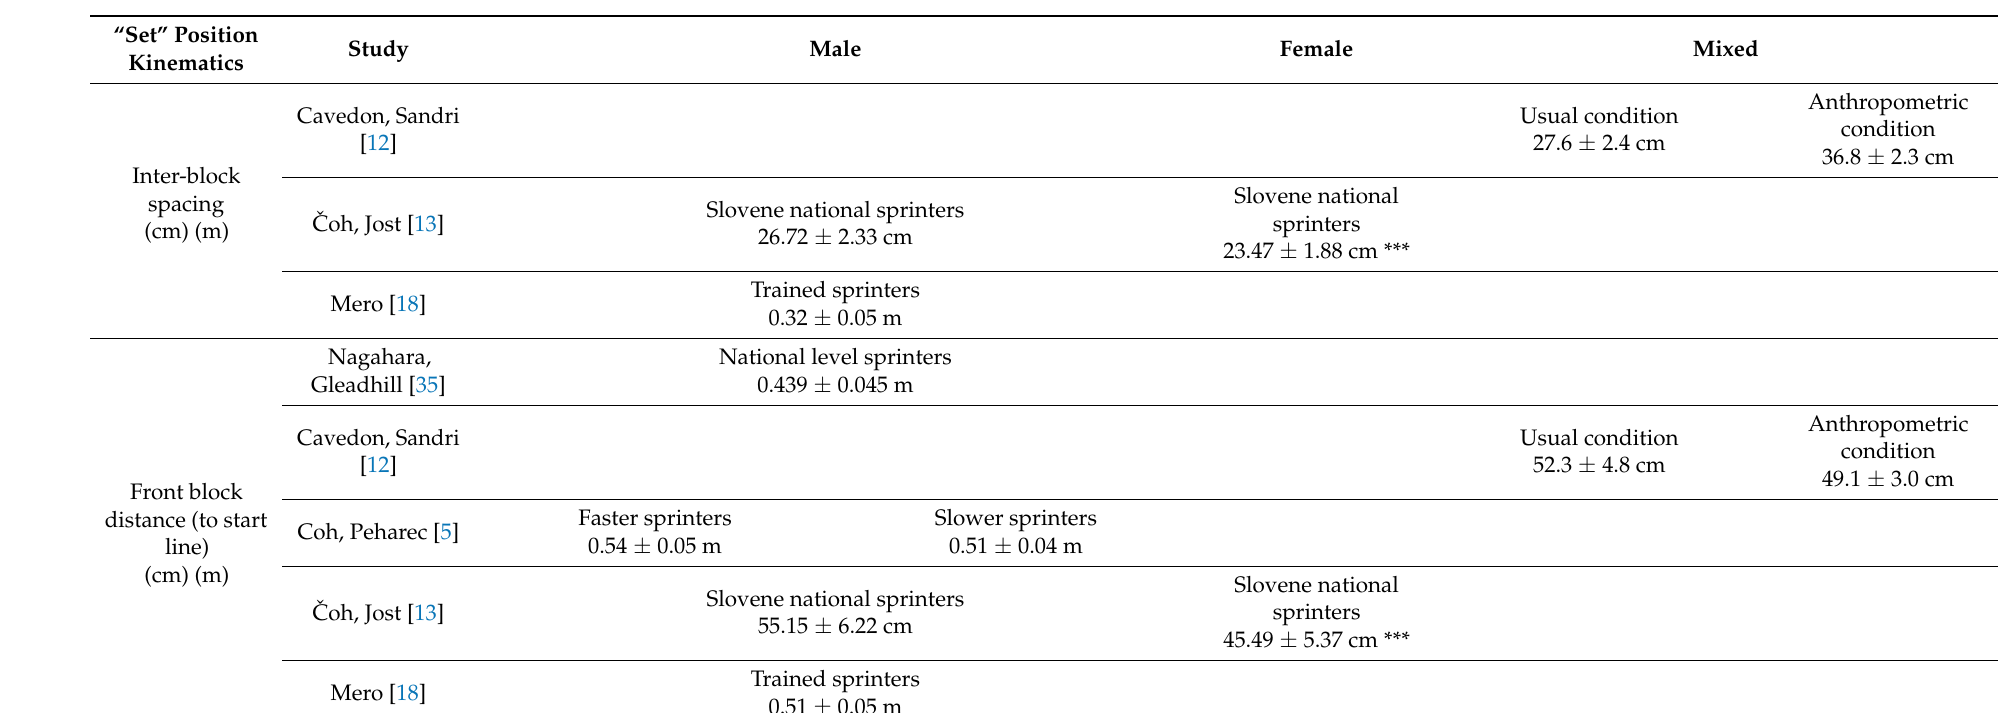
Table A1. Summary of the kinematic variables in the “Set” position. Data are the magnitude of the mean ± SD presented in the reviewed studies. Groups are male, female, and mixed (when authors joined data without discriminating by sex) sprinters. Studies are listed, in each variable, in reverse chronological order. Data, terms, conditions, and sprinters’ performance levels are presented according to the original authors. Statistical differences between groups are marked with asterisks (* p < 0.05; *** p <